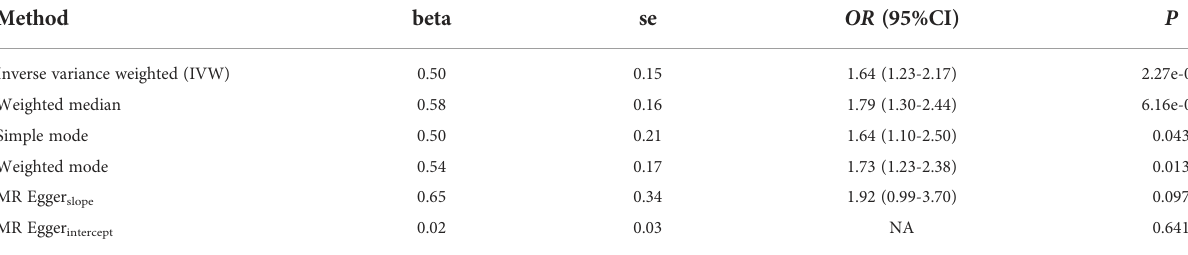
TABLE 2 Associations between leukocyte TL and Graves ’ disease using Mendelian randomization